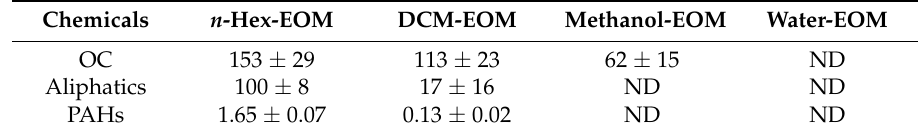
Table 1. Chemical characteristics of DEP-EOMs. Total OC, aliphatic hydrocarbons (Aliphatics), and PAHs in the different DEP-EOM from [16]. Data are expressed as mean ± SD of three separate extractions. All values in mg/g of original native